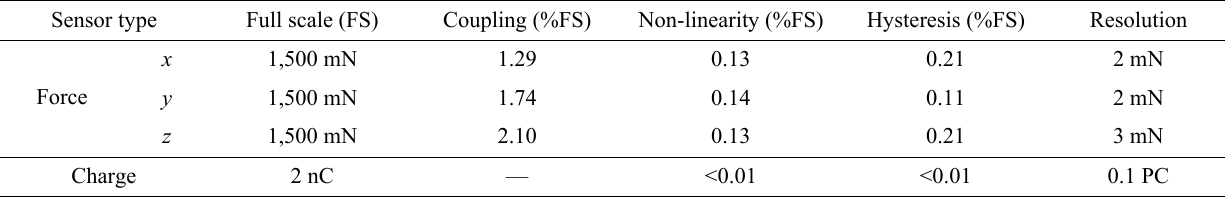
Table 1 Summary of the performance of the sensors.